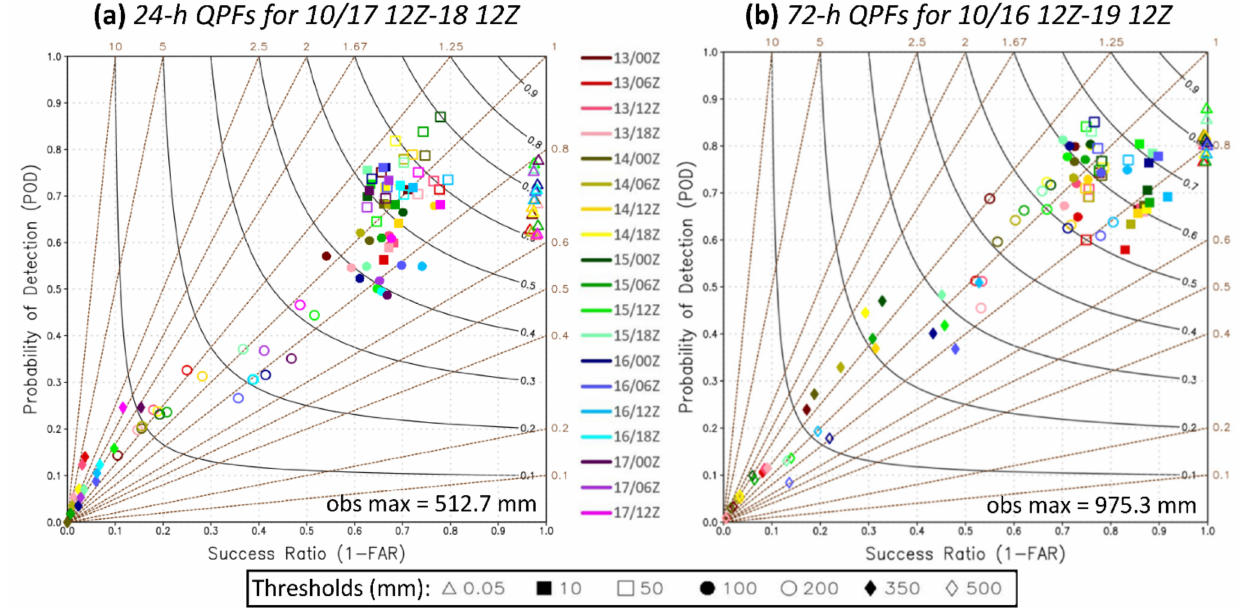
Figure 12. As in Figure 7, except for ( a ) 24 h QPFs targeted for 1200 UTC on 17 to 1200 UTC on 18 October and ( b ) 72 h QPFs for the combined period (from 1200 UTC on 16 to 1200 UTC on 19 October) during TY Koppu (2015) at thresholds from 0.05 to 350 mm (symbol), plus 500 mm in ( b